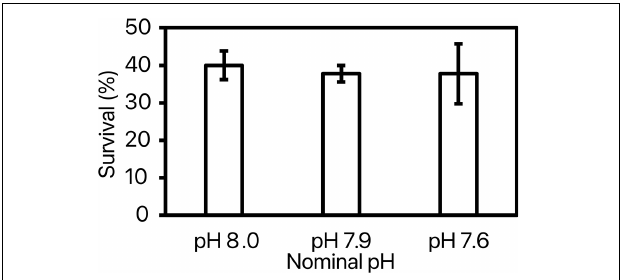
FIGURE 1 | Percentage of shrimp surviving until the end of the experiment in each nominal pH NIST .